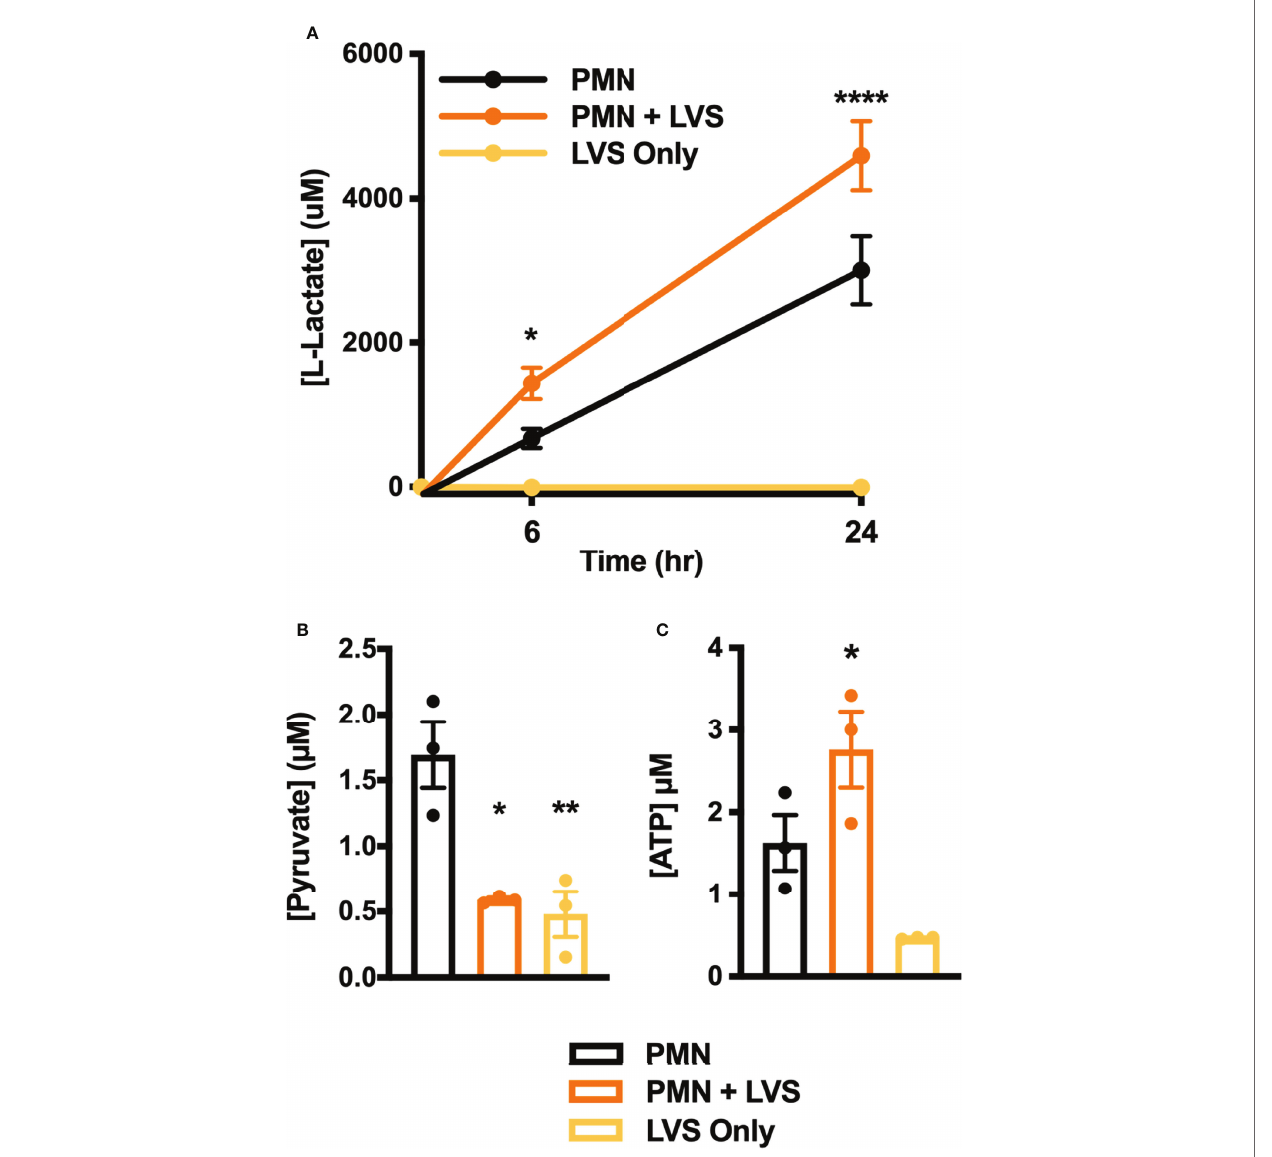
FIGURE 3 | Differential effects of LVS on PMN lactate, ATP, and pyruvate. (A) Amount of lactate released by control and infected PMNs or LVS alone at 0, 6 and 24 hpi, n=3-4. **** p < 0.0001, * p < 0.05 vs. uninfected control cells at the indicated time points. (B, C) Pyruvate (B) and ATP (C) levels of control and infected PMNs or LVS alone at 24 hr, n=3. * p < 0.05, ** p < 0.01 vs. control PMNs as